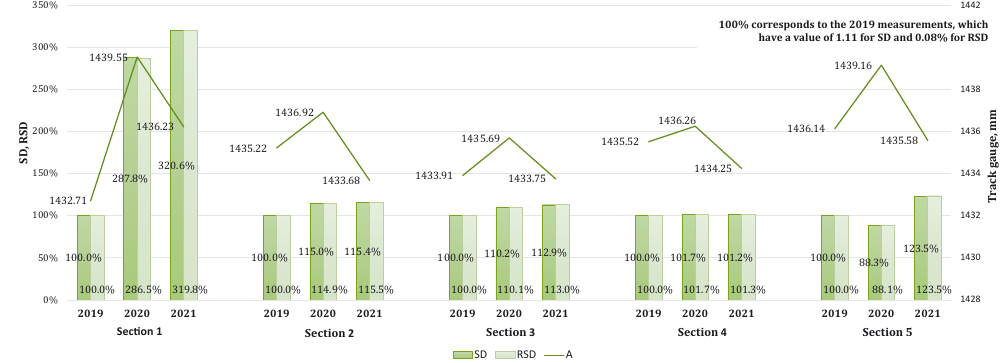
100% corresponds to the 2019 measurements, which have a value of 1.11 for SD and 0.08% for